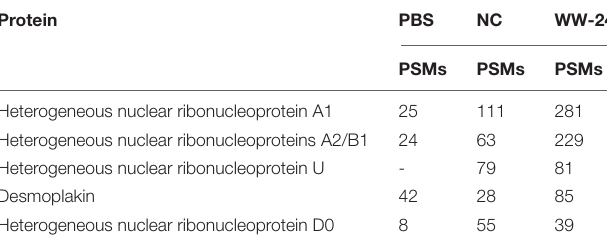
TABLE 2 | Target protein of aptamer